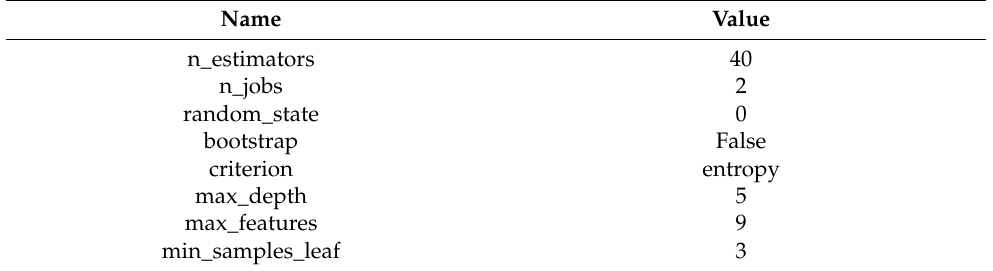
Table 2. Hyperparameters of the RF algorithm for definition of the feature